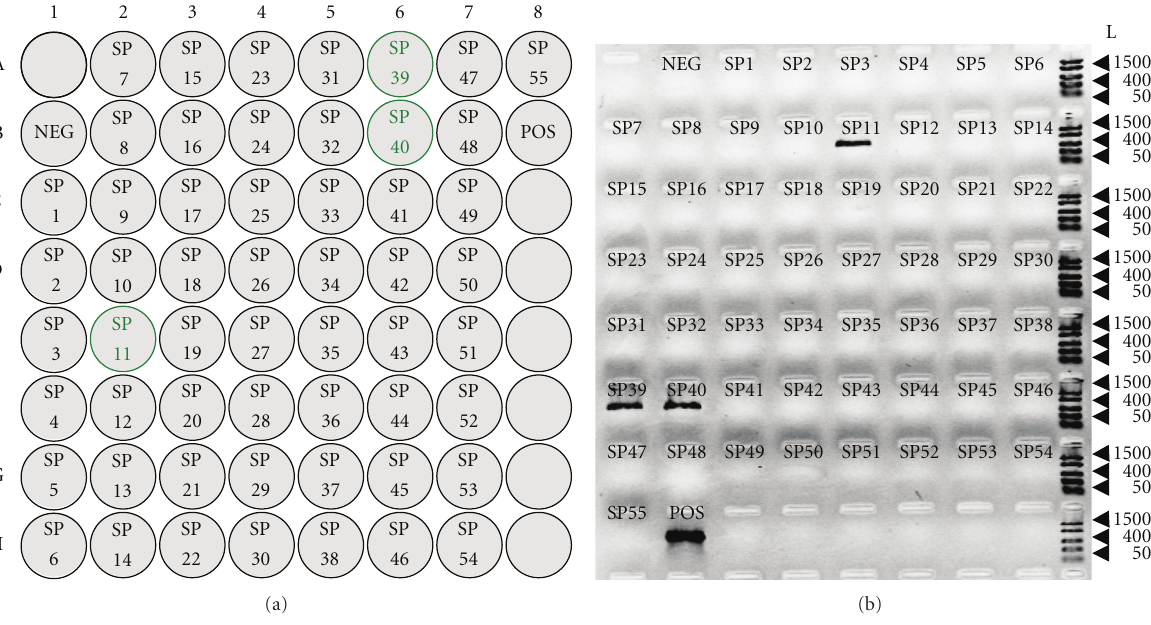
Figure 2: Results of super pool (SP) screening for the barley BAC library HVVMRXALLeA. (a) Schematic representation of 55 barley super pools originated from the BAC library HVVMRXALLeA [24]. SP1 to SP55 represent the super pools 1 to 55. Each super pool is composed of 7 × 384 microtiter plates, that is, 2688 BACs per super pool. NEG: negative control. POS: positive control, in this case genomic DNA of the barley cultivar Morex where the BAC library was derived. (b) Ethidium-bromide-stained agarose gel (1.5%) image of the super pool screening. Only the positive super pools (highlighted with a green border in (a)) amplified a single fragment that is of identical size to the product in Morex. Arrowheads indicate in each panel the position of the 1500, 400, and 50bp fragments of the FastRuler Low Range marker (Fermentas). L (size standard in bp).